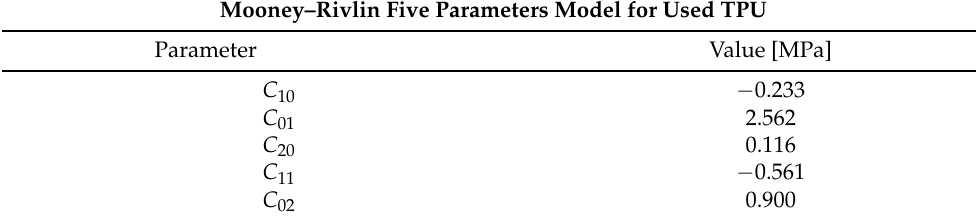
Table 3. Mooney–Rivlin Five Parameters model for used